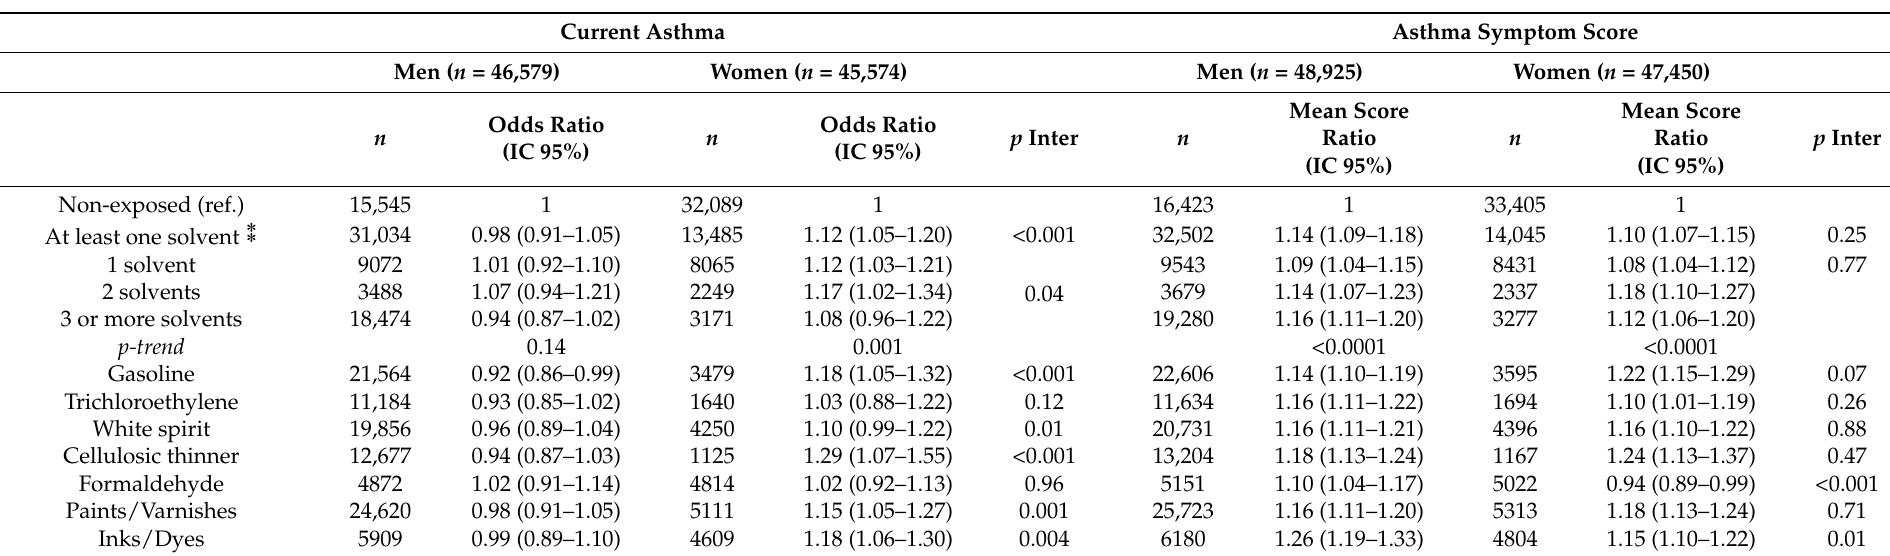
Table 3. Association between lifetime occupational exposures to solvents assessed by the JEM and current asthma or asthma symptom score.